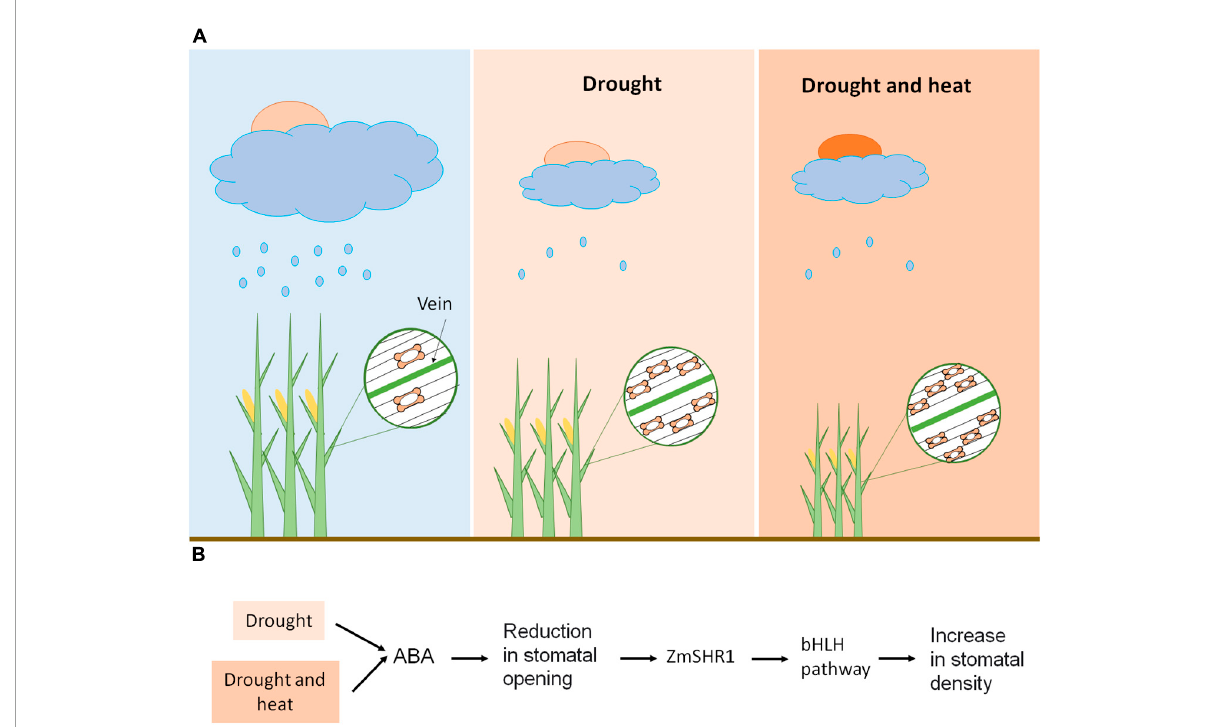
FIGURE2 Maize stomatal response to climate change. (A) Heat enhances the maize stomatal responses to drought stress. Drought reduces stomatal size and opening, and increases stomatal density, which, in turn, reduces transpiration and photosynthetic rate. When drought and heat coexist, plants experience a reduction in transpiration rate and photosynthetic rate, possibly related to a reduction in stomatal size and opening, accompanied by an increase in stomatal density. This triggers a reduction in biomass accumulation, which is more severe than that induced by drought stress. (B) Possible molecular mechanisms of stomatal response to climate change. Drought stress, individually or in combination with high temperatures, reduces stomatal opening by increasing abscisic acid (ABA) levels. This stomatal response could trigger the increase of the distance of action of ZmSHR1 from the longitudinal leaf veins. ZmSHR1 might act to positively regulate ZmSPCHs/ZmICE1 heterodimers, increasing the number of stomatal files and, consequently, the stomatal